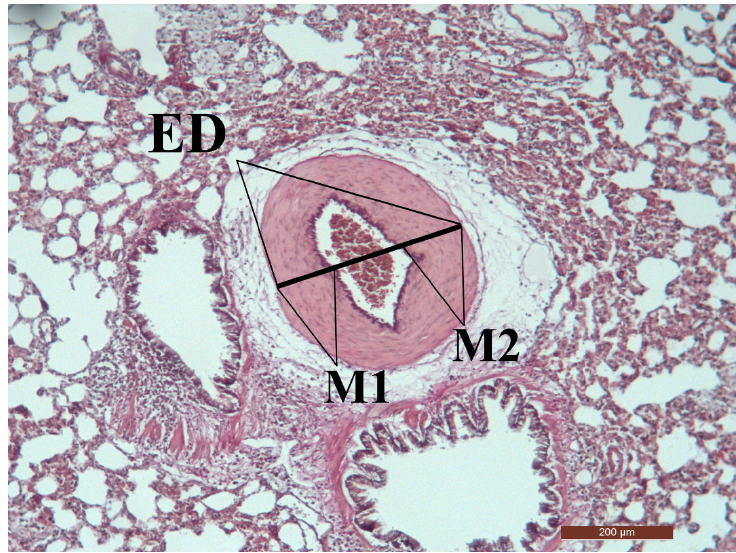
Figure 6. Morphometric analysis of pulmonary arteries in a study rat. The mean external diameter (ED), across the smallest diameter, and the medial wall thickness between the internal (ID) and external elastic lamina of two sides of pulmonary arteries (ED − ID = M1 + M2) were measured. The percentage of medial wall thickness (MWT) was calculated as follows: % MWT = (M1 + M2)/ED × 100 (EVG staining, PAH group, magnification: 100×).